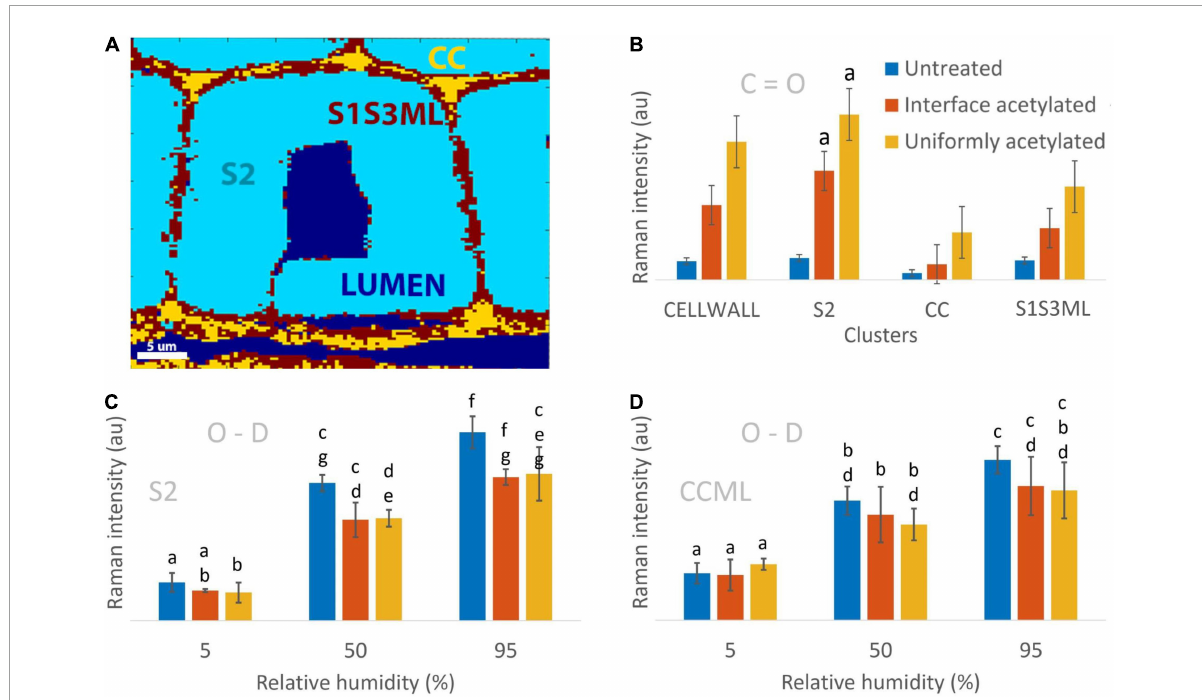
FIGURE3 Quantification of the Raman O-D and C=O signals in the different clusters of the cell wall. (A) Example of the wood cell clustering depicting LUMEN (tracheid and ray cell lumina), S2 (secondary cell wall), CC (cell corners), S1S3ML (primary and tertiary cell wall, and middle lamella). The CELLWALL cluster (not shown) is the sum of the S2, CC and S1S3ML clusters, i.e., the whole cell wall. (B) Average Raman C=O intensity computed for untreated, interface acetylated and uniformly acetylated wood by averaging the images from the three replicates and the three hygroscopic states for each cluster (9 images contributed to the average and standard deviation of each bar). (C,D) Average Raman O-D intensity calculated for the three materials in the three hygroscopic states for S2 and CCML clusters. All Raman intensities are normalized over the lignin peak height at 1,601 cm − 1 . In (B–D) untreated samples are illustrated by blue bars, interface acetylated samples by red and uniformly acetylated samples by yellow. The bars include the standard deviation. The bars were compared using a two-tailed pair t -test for significance with the null hypothesis of no difference between the two set of data and α = 0.05. The letter a on top of the bars in (B) indicates that the interface and uniformly acetylated belonging to the S2 cluster were the only results not rejecting the null hypothesis of equal signal for all three